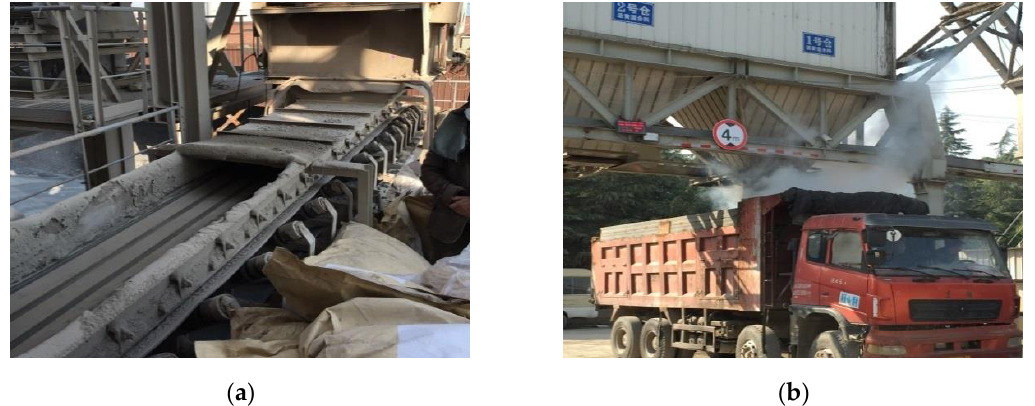
Figure 13. Feeding and charging process: ( a ) High-viscosity modifier feed port; ( b ) A truck being loaded.